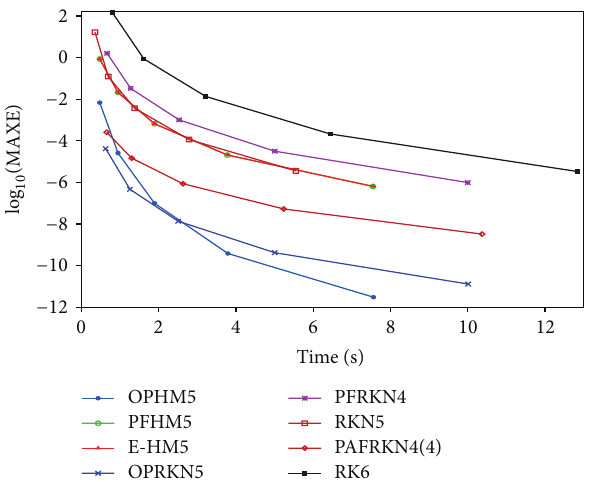
Figure 5: The efficiency curves of the optimized and phase-fitted order five methods and their comparisons for Problem 6 with 𝑡 10 4 and ℎ = 0.125/2 𝑖 , 𝑖 = 1, ...,5 .